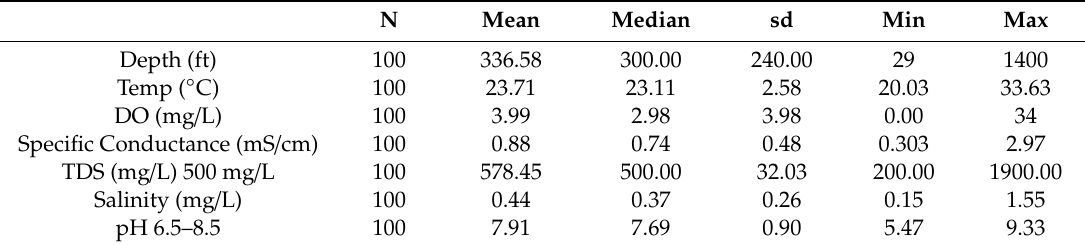
Table 4. Descriptive statistics for the wells sampled and associated parameters measured.